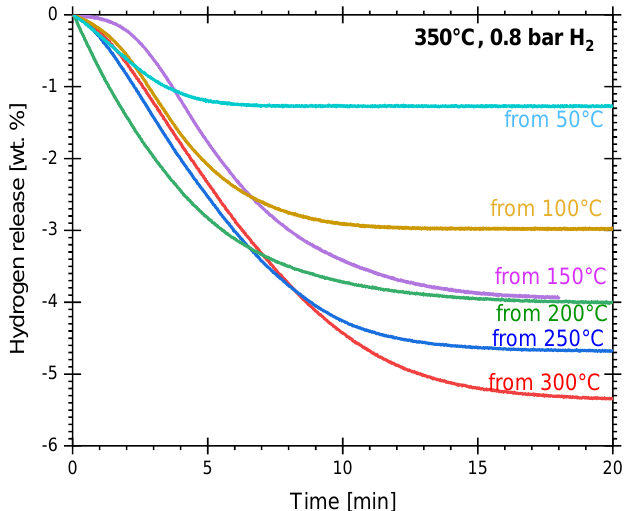
Figure 3. Isothermal dehydriding of cryogenically prepared Mg-15wt.% VCl 3 , previously hydrided at the indicated temperature. All dehydrogenations at 350 ◦ C and 0.8 bar. An additional isothermal hydriding/dehydriding cycle at 320 ◦ C, 12 bar and 1 bar,